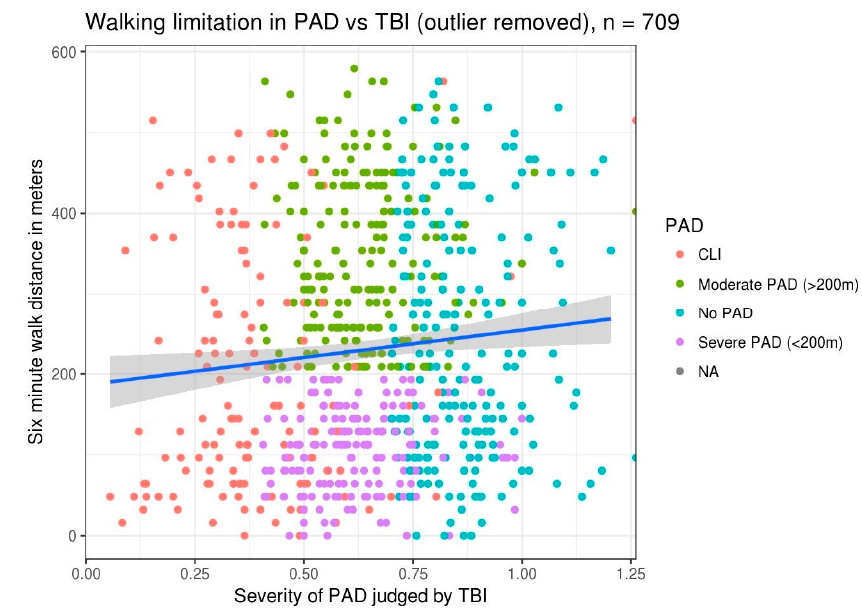
Figure 1. Six-minute-walk-test (6MWT) distance versus toe–brachial index (TBI): This illustrates a slight improvement in walk distance with improvement in TBI values. The scatterplot of individual patient data is colored by severity of peripheral arterial disease (PAD), as outlined in the legend. A linear regression line illustrating the relationship between walk distance in meters and TBI is overlaid on the data. CLI: critical limb ischemia.